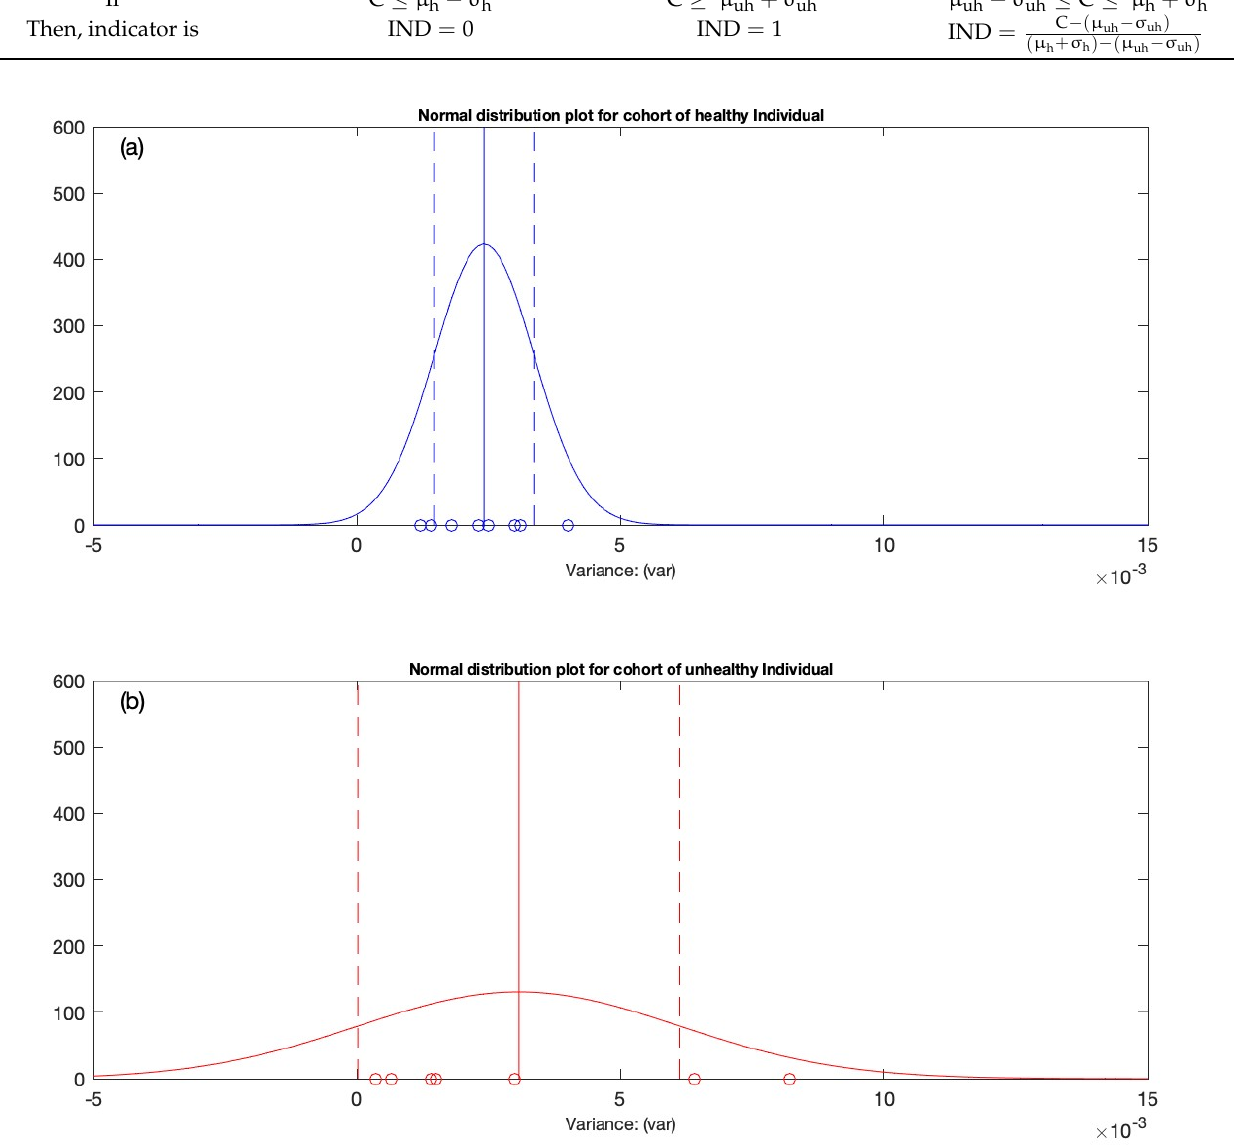
Figure 4. The distribution of individuals in each cohort is approximated by the Gaussian distribut-ion. ( a ) The Gaussian distribution plot computed for the cohort of healthy individuals. ( b ) The Gaussian distribution plot computed for the cohort of unhealthy individuals.